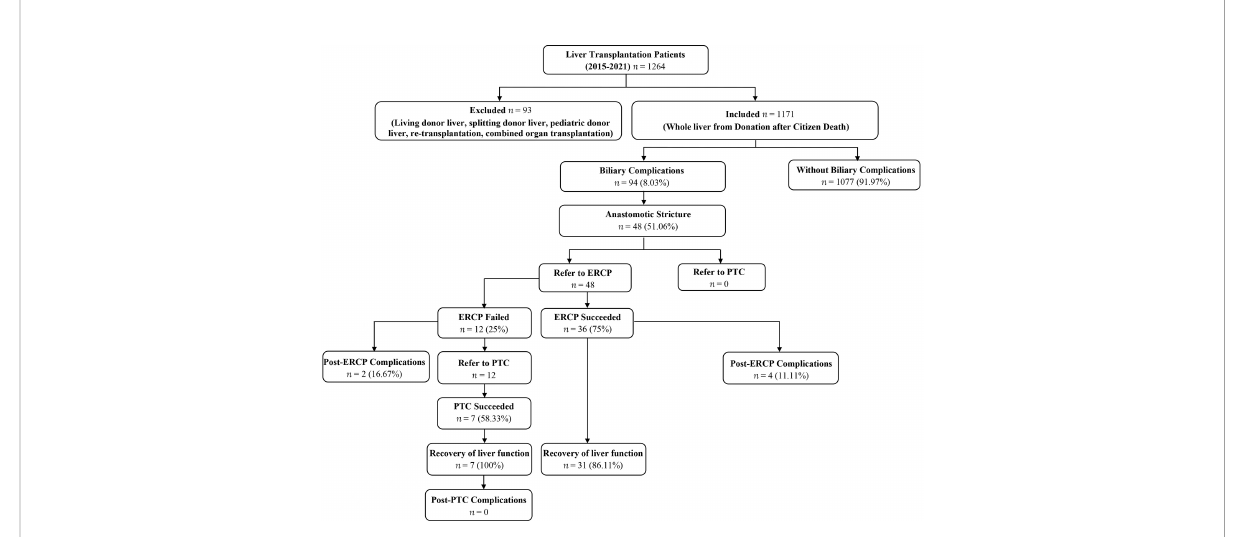
FIGURE 1 Schematic of study design and procedural data of liver transplantation